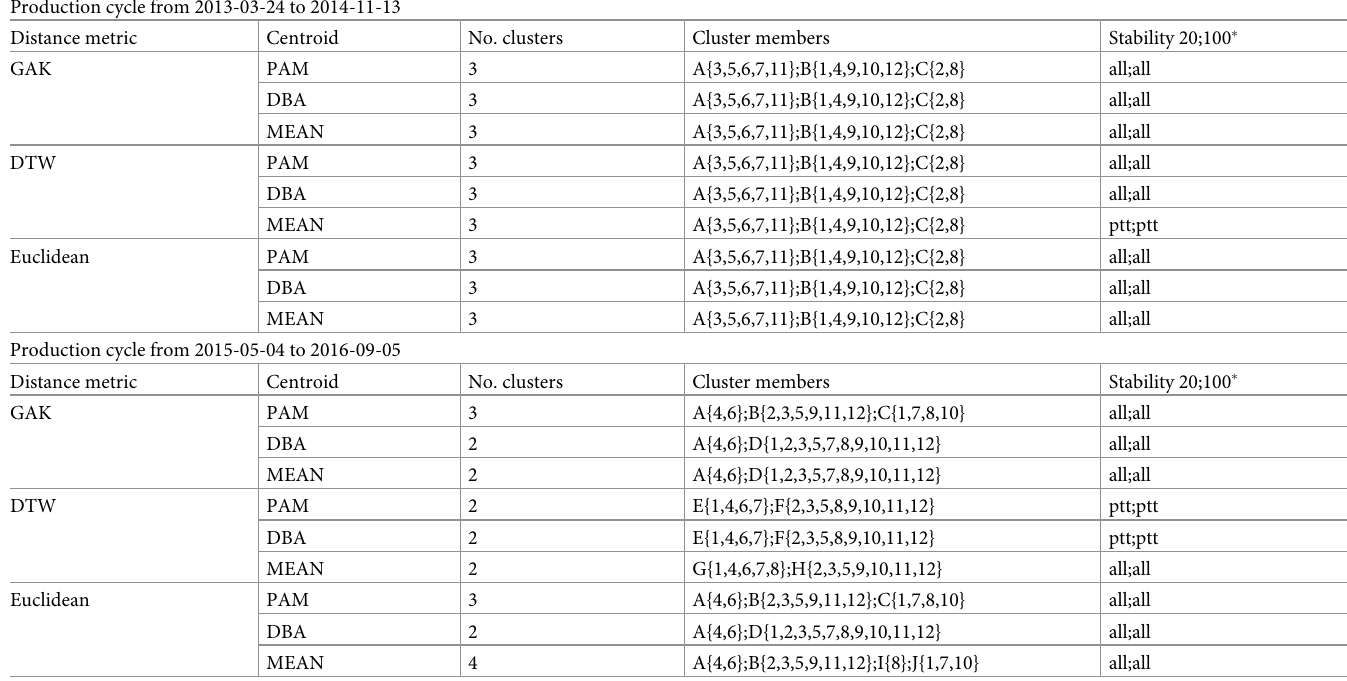
Farm III, for 2015 to 2016, included clustering of cages 4 and 6, two cages subject to sorting and splitting. Here the largest fish were selected and kept in their cage, raising the weight at harvest in these two cages. Examples suggesting weight and management as driving forces behind sea lice clustering also occurred at Farms I and II. Further research into the potential for management factors to influence clustering between cages should be investigated. Table 4. Clustering results for Farm III. The most stable clusters are identified per cycle,